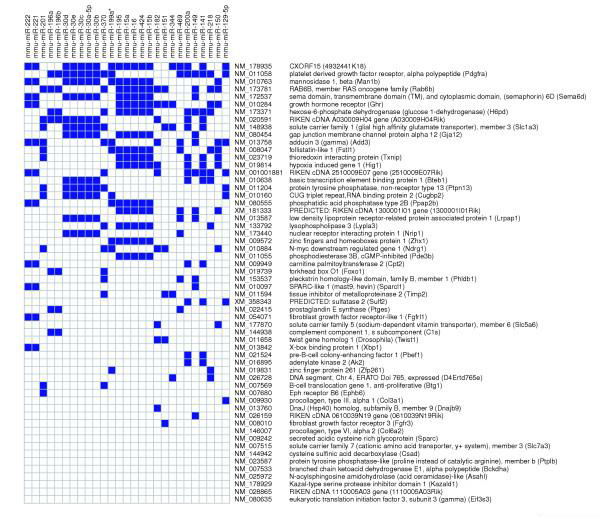
Genes in cluster 9 and significantly over-represented miRNA motifs (blue squares). miRNA, microRNA.